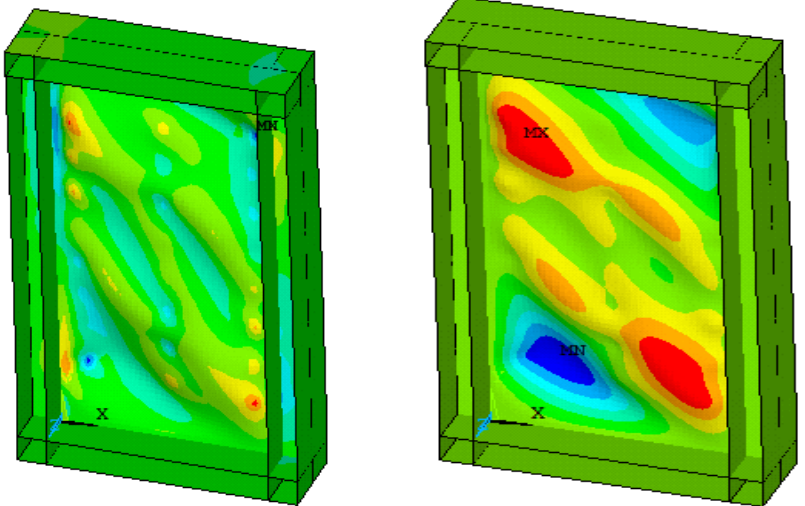
Figure 7. Local buckling, out-of-plane deflection for numerical specimen.